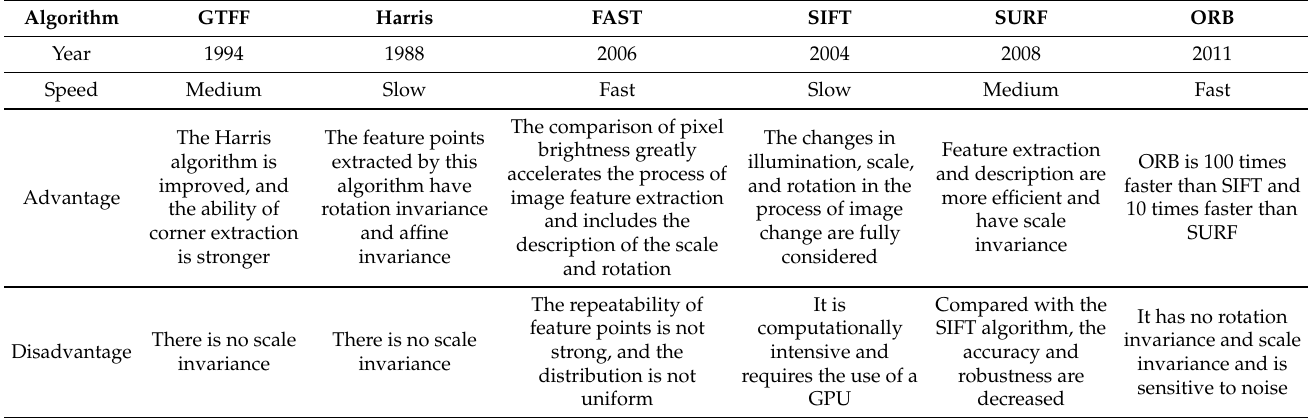
Table 5. Commonly used feature extraction algorithms in SLAM.